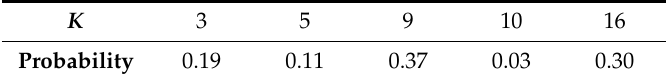
Table 3. The probability mass function of random variable K for our second example.